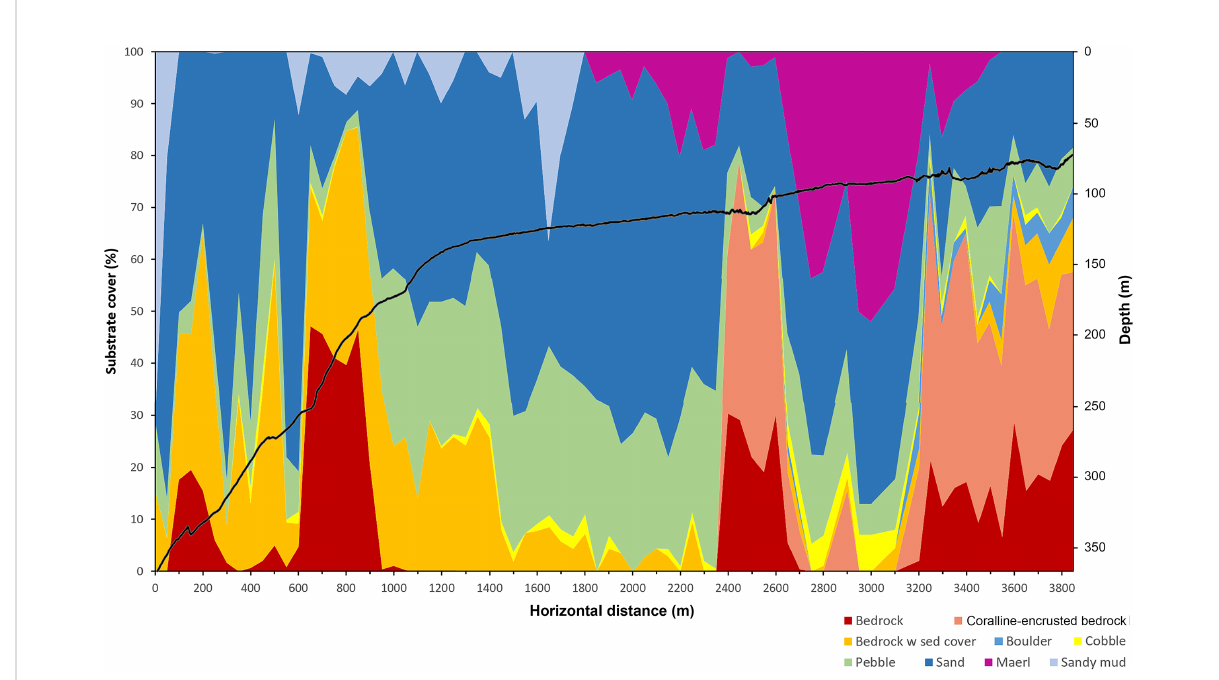
FIGURE 5 Depth pro fi le (solid line) along the transect surveyed with the submersible LULA1000 and composition of substrate types shown as percentage seabed surface cover (estimated as average percentage within 50m video